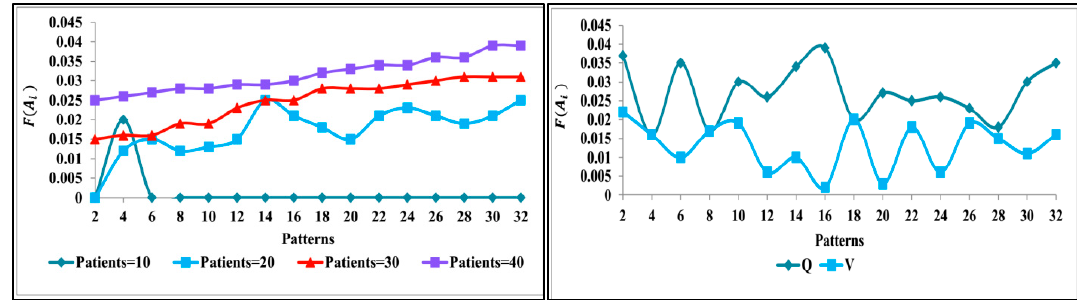
Figure 8. 𝐹(𝐴 (cid:3036) ) a nalysis. Figure 8. F ( A i ) analysis.